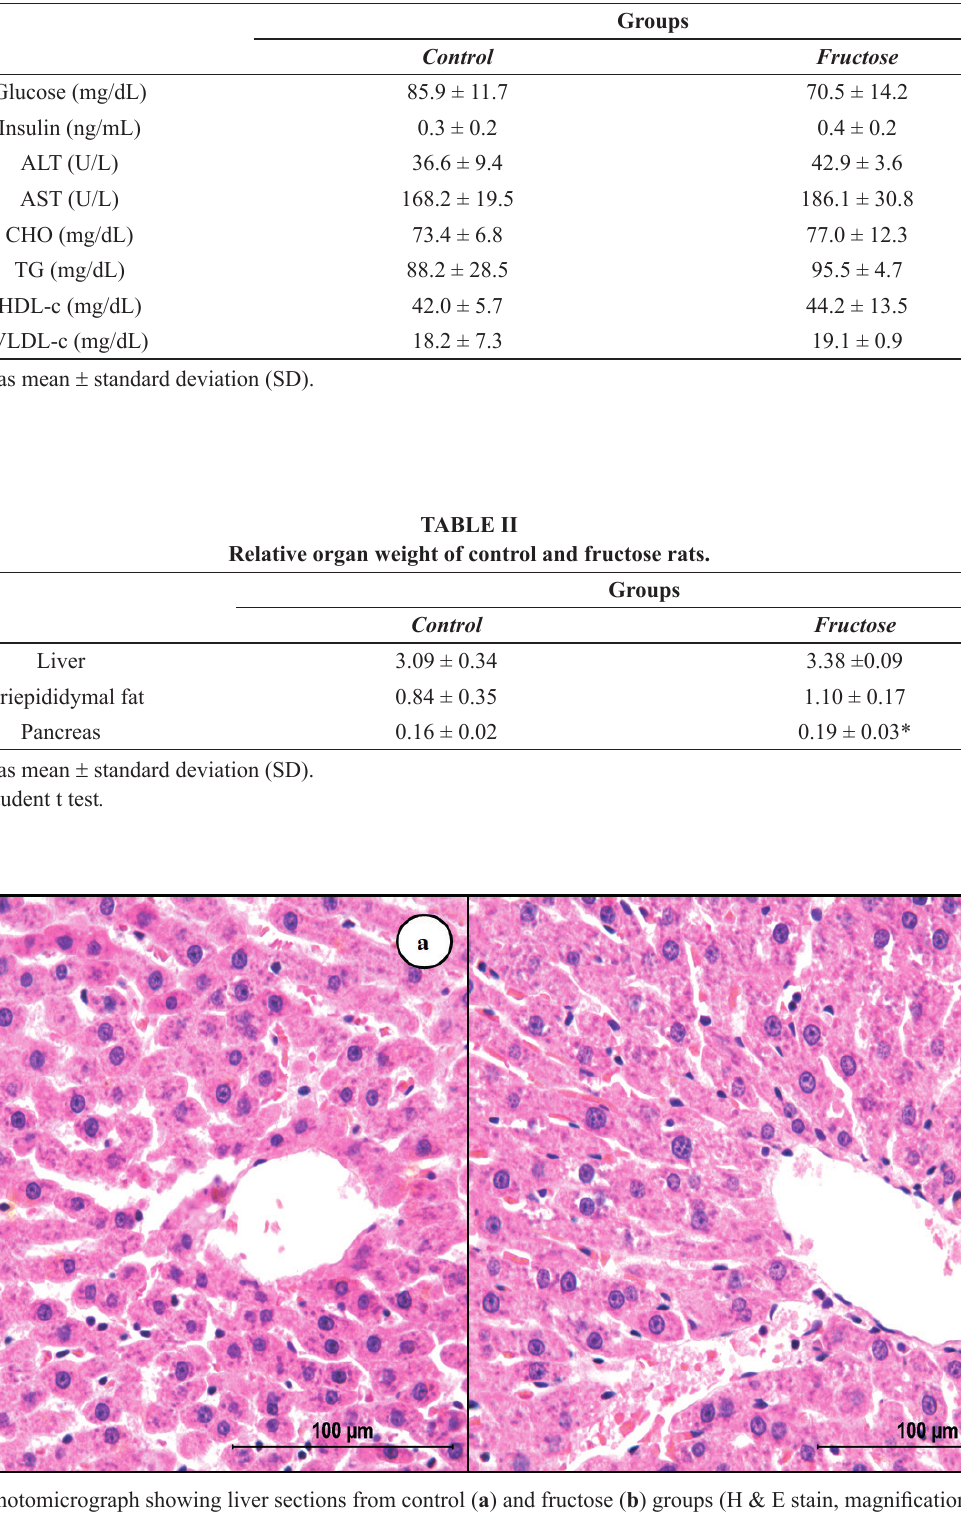
Biochemical profile of control and fructose rats.